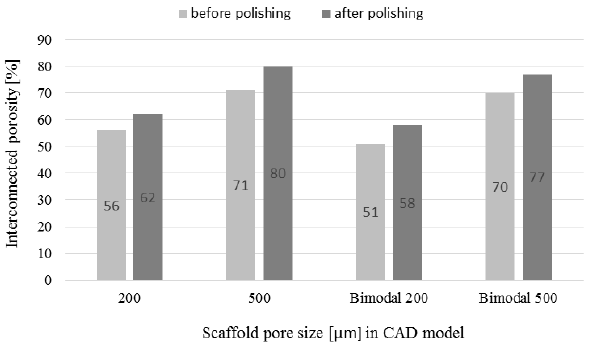
Figure 11. Scaffolds’ open porosity (average values) before and after chemical polishing measured by µ-CT method.